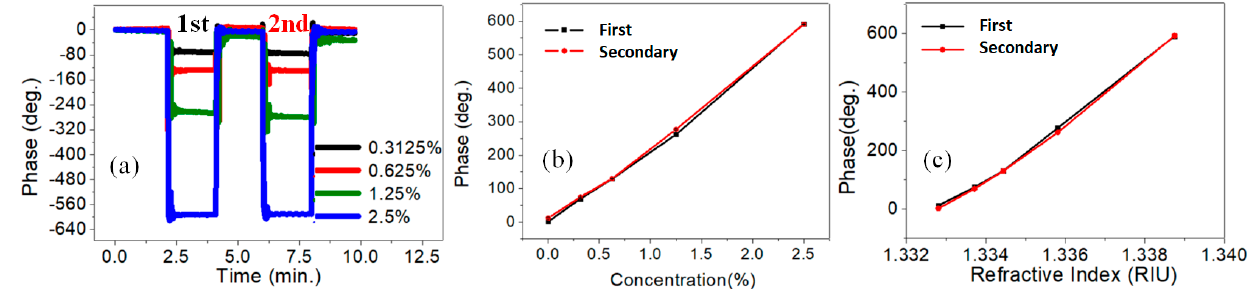
Figure 5. HCl solution measurements with five polyethylene terephthalate (PET) layers at 40° incident angle. ( a ) Phase variations by alternately exchanging the pure water and the different HCl concentration. ( b ) Phase versus concentration. ( c ) Phase versus the refractive index.